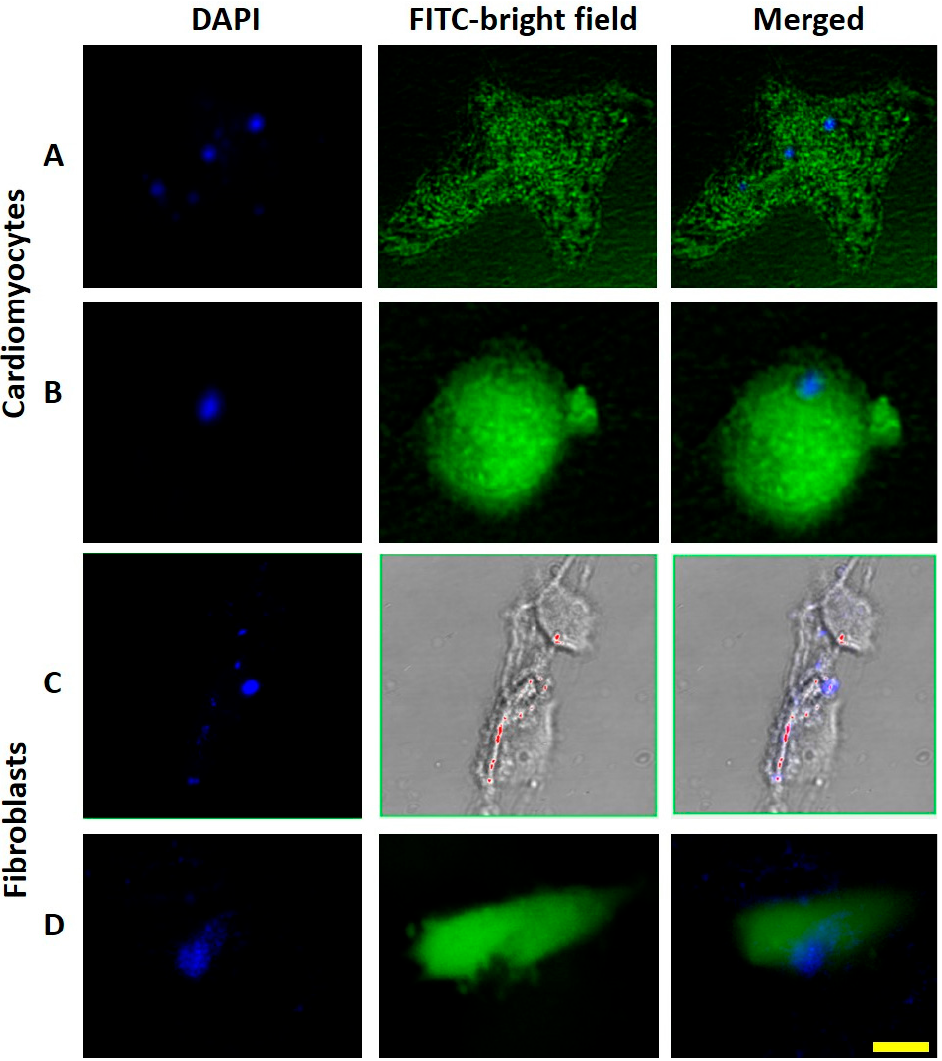
Figure 3. Confocal microscopy images of self-fluorescent and agglomerated PPNPs (observed with a DAPI filter), the cell (stained with calcein using a FITC filter and a bright field filter, respectively), and both together (merged). The PPNPs captured in the cardiomyocytes ( A , B ) and fibroblasts ( C , D ) upon incubation time of 24 h. The yellow scale is 25 μ m.